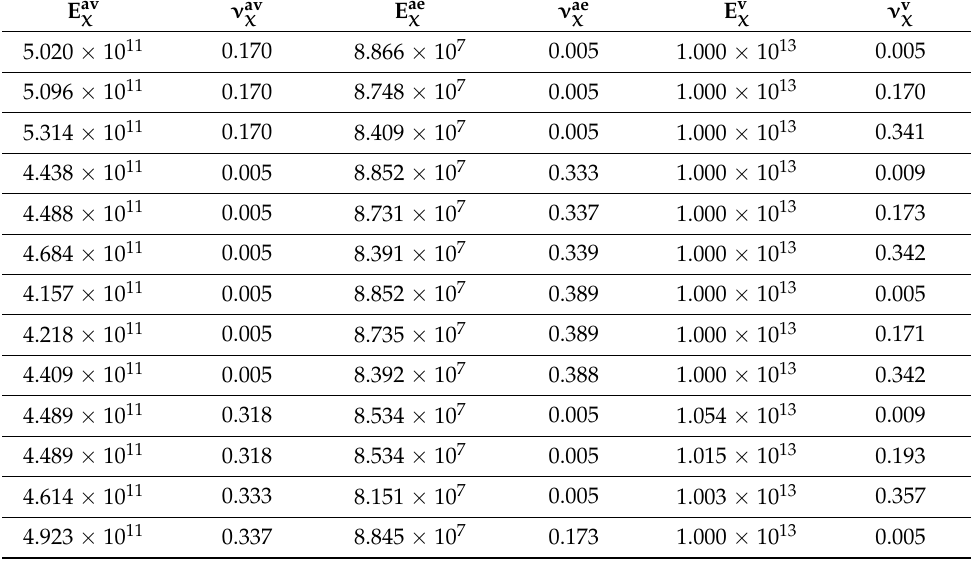
Table A2. Inverse identification results for the case n = 3 ( I 1 = [ 0.05,0.17 ] , I 2 = [ 0.17,0.34 ] and I 3 = [ 0.34,0.5 ]